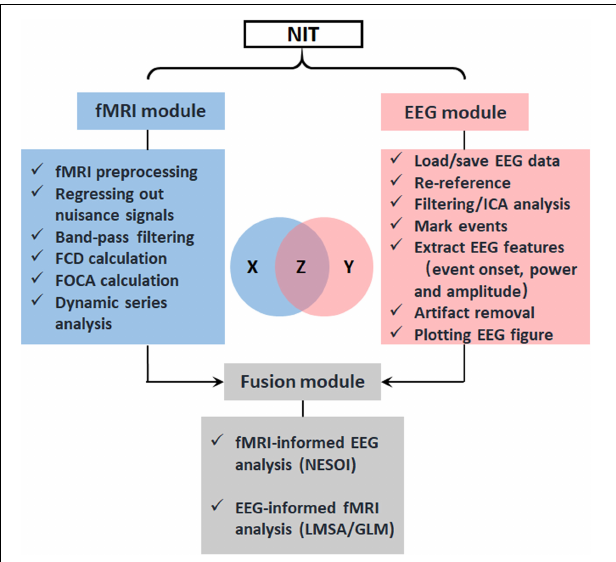
FIGURE 2 | Design of NIT. NIT is designed as a convenient GUI, and it consists of fMRI, EEG and fusion modules. Conceptually, the EEG–fMRI multimodal fusion can be represented as information theoretic quantities, which are displayed as areas in a Venn diagram. X is corresponding to fMRI BOLD recordings, Y is corresponding to EEG electrophysiological signals, and Z is common information between EEG and fMRI revealed by fusion methods.